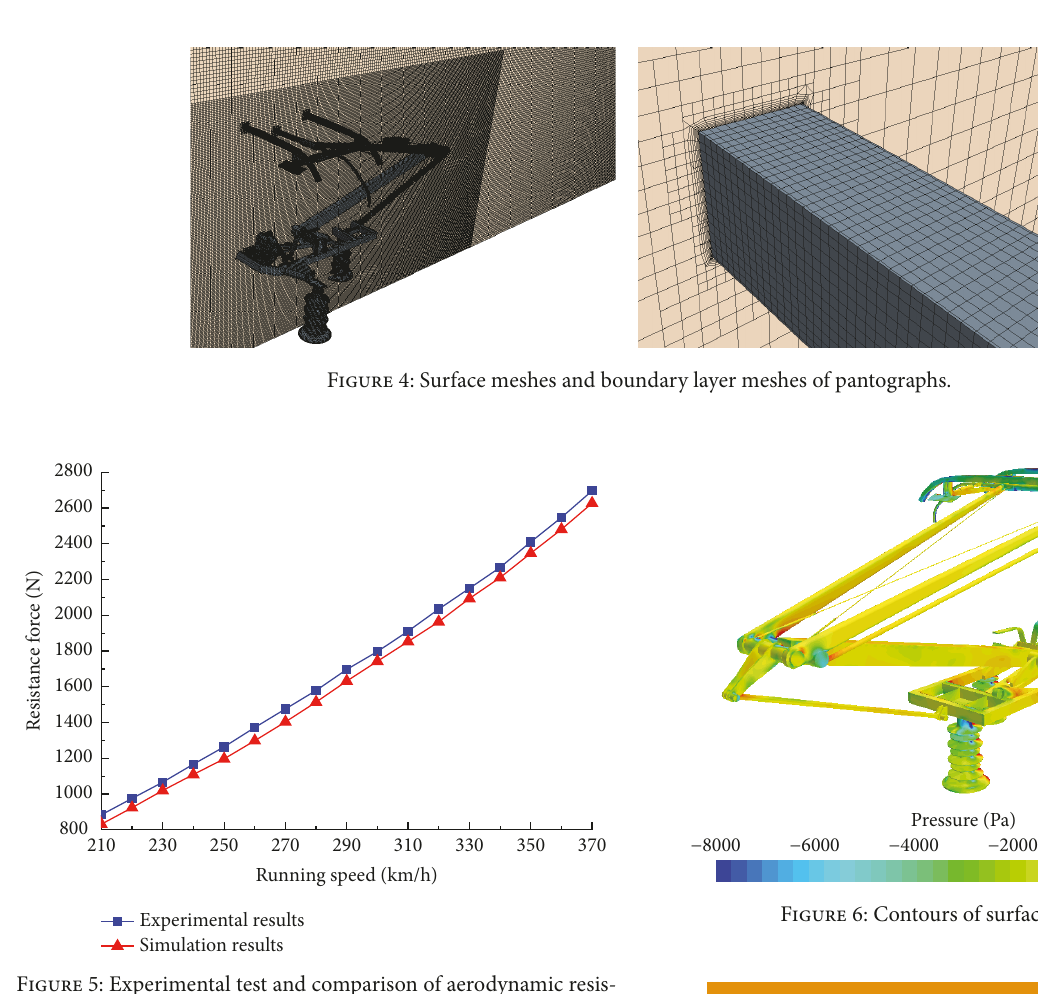
Figure 5: Experimental test and comparison of aerodynamic resis- tance for pantographs.